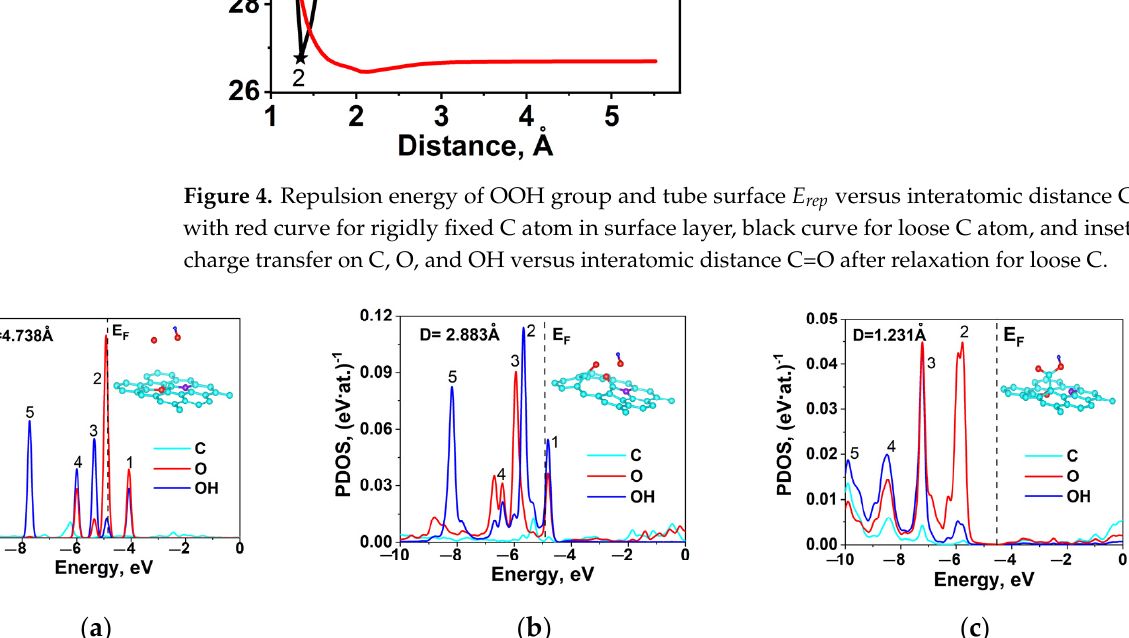
Figure 5. PDOS of carboxyl components C, O, and OH for three different distances in bond C=O with inset showing respective spatial positions of O and OH relative to tube surface: ( a ) 4.738 Å; ( b ) 2.883 Å; ( c ) 1.231 Å.